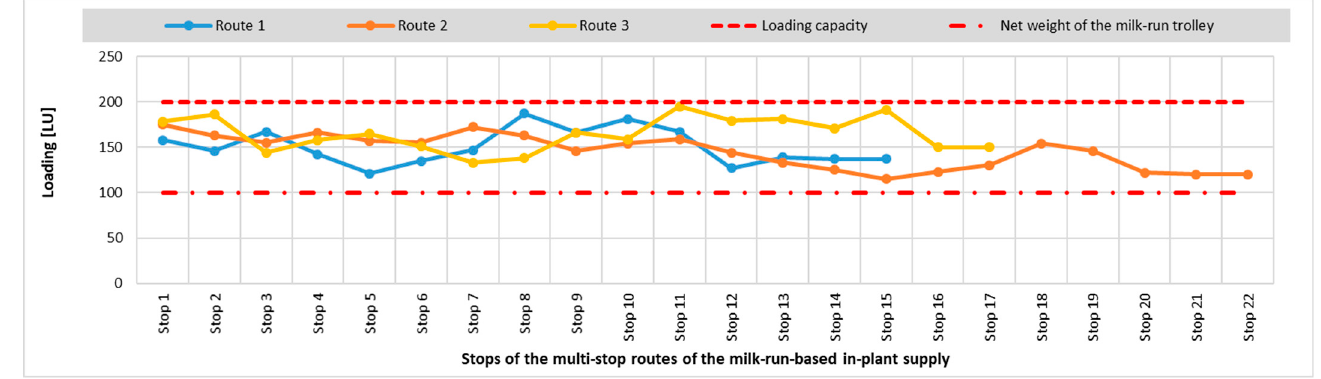
Figure 14. The optimized loading of the three milk-run trolleys.